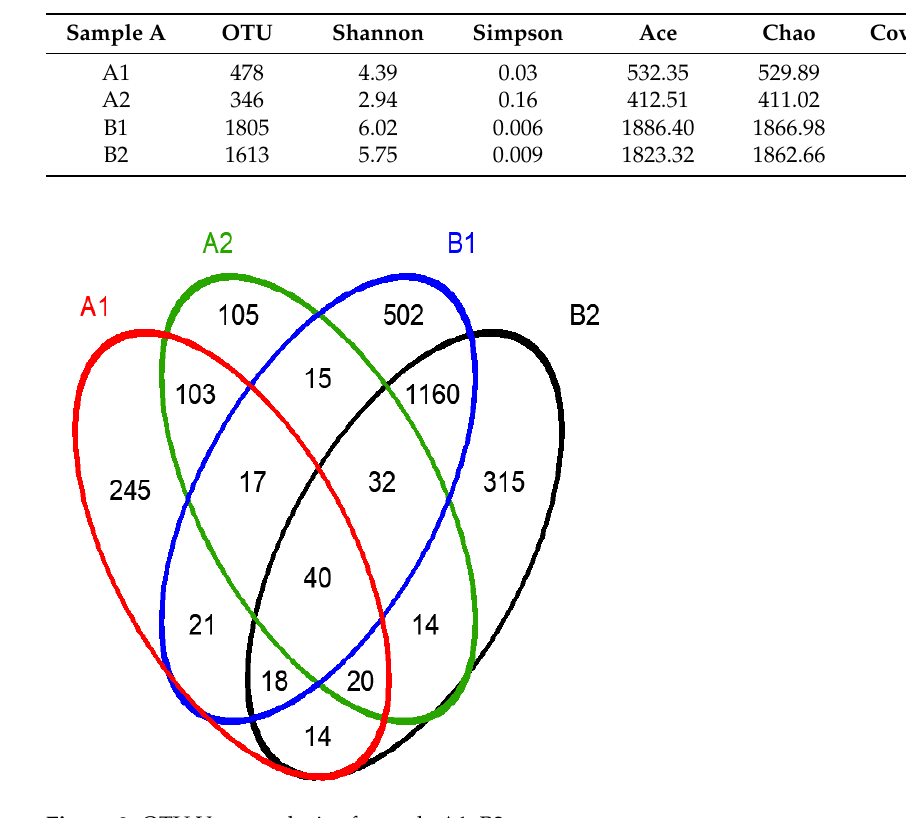
Table 3. The OTU numbers and bacterial diversity indices of sludge samples.